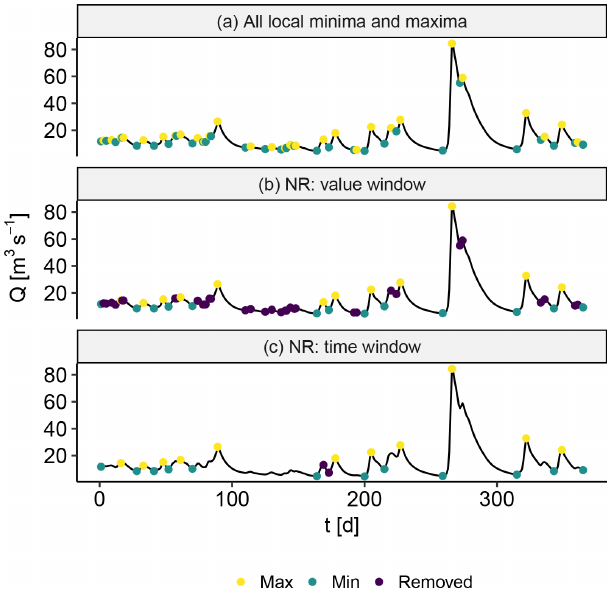
Figure 3. (a) All local minima and maxima. (b) Removal of noise using the value window. (c) Removal of noise using the time win-